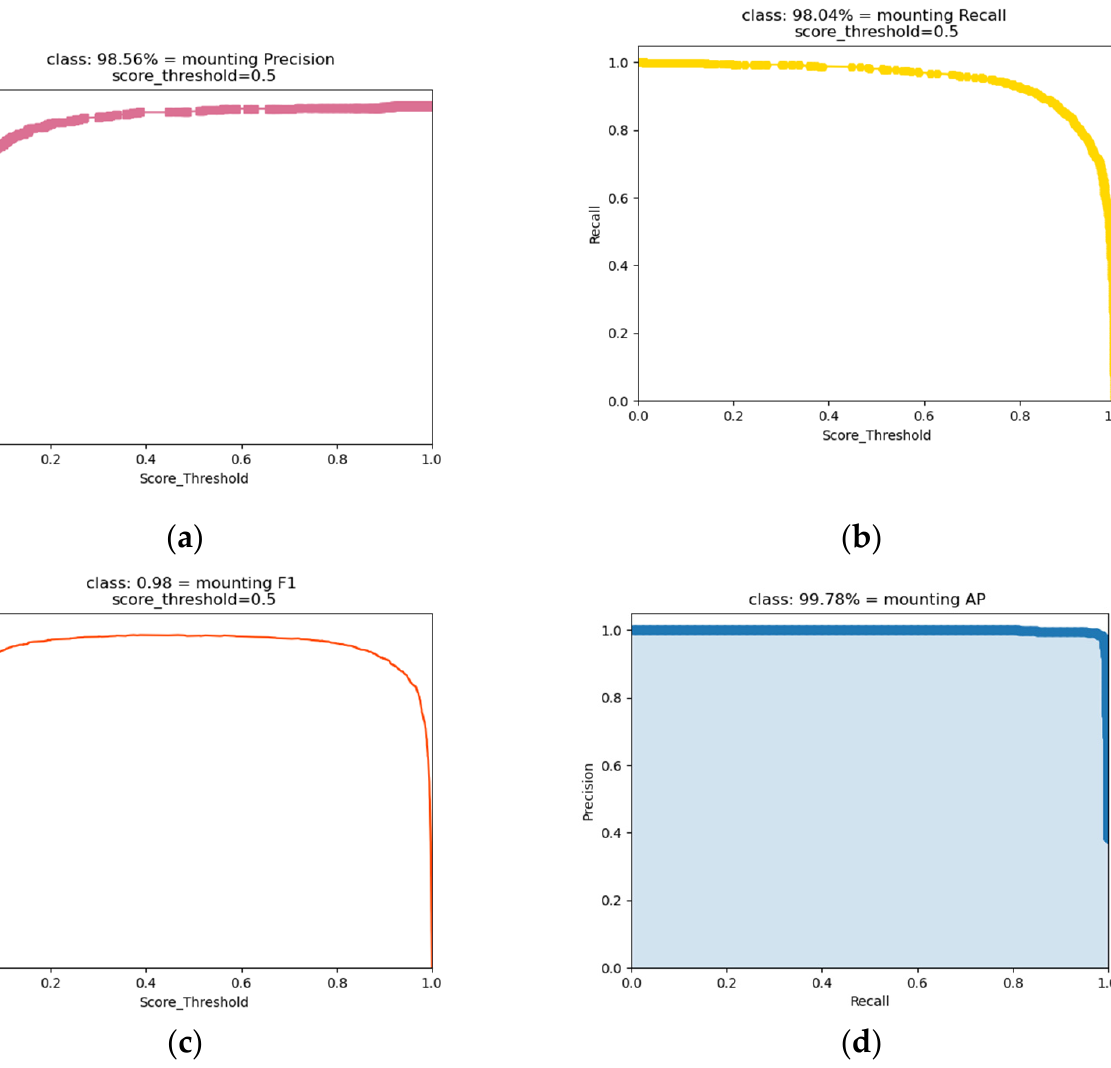
Figure 11. Variation of each index with threshold: ( a ) Curve of P value changing with threshold; ( b ) Curve of R value changing with threshold; ( c ) Curve of F1 value changing with threshold; ( d ) Curve of AP value changing with threshold.